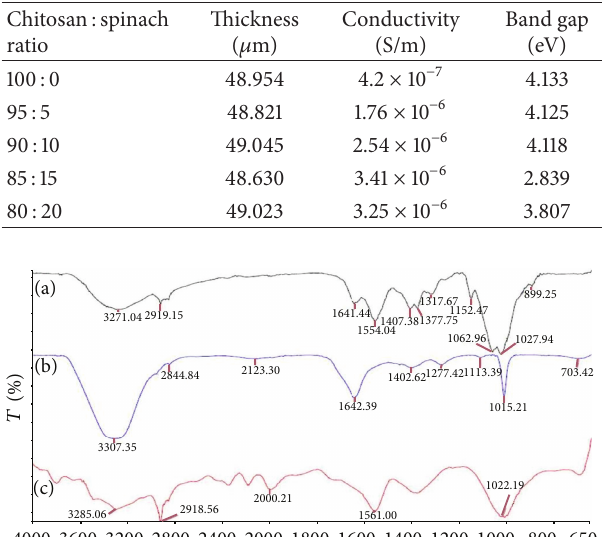
Figure 2: Infrared spectra of (a) chitosan film, (b) spinach extract, and (c) chitosan-spinach blend